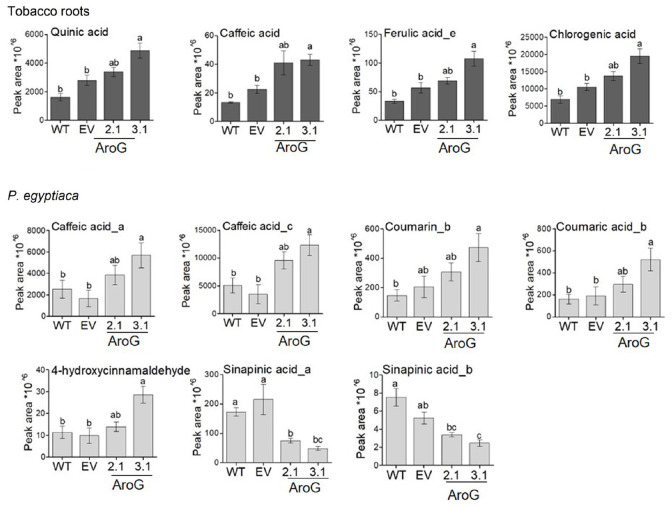
Levels of phenylpropanoids as detected by LC–MS/MS analysis in roots and in the parasite. Levels of the compounds in transgenic AroG lines #2.1 and 3.1, EV and WT (dark gray) and Phelipanche aegyptiaca attached to the roots of these plants (light gray). Data are presented as the mean ± SE of six different plants. Different letters represent statistical significance (p ≤ 0.05), which was determined using the Tukey-Kramer test. The figure shows only the phenylpropanoids that changed significantly.